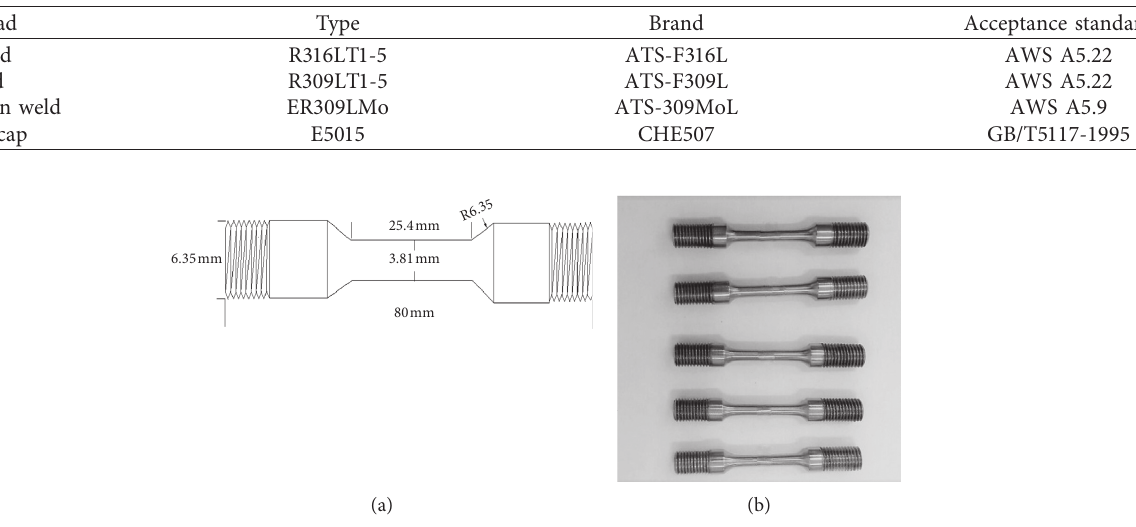
Table 2: Material components of weld seams.